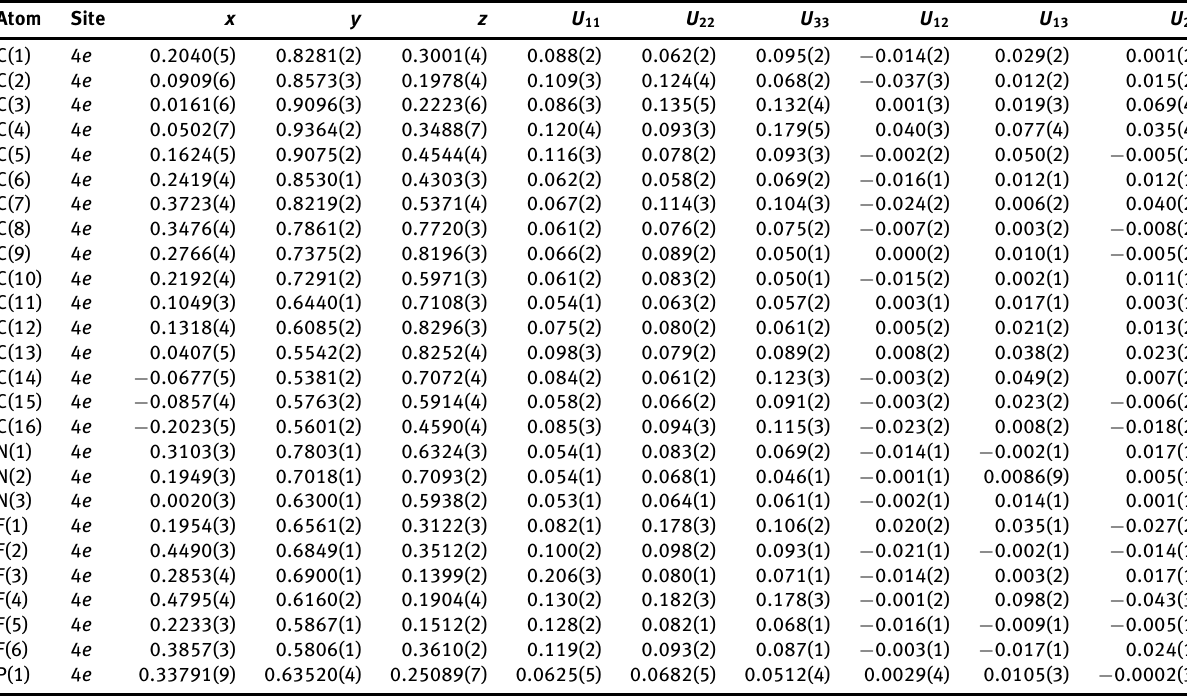
Table 3: Atomic displacement parameters (Å 2